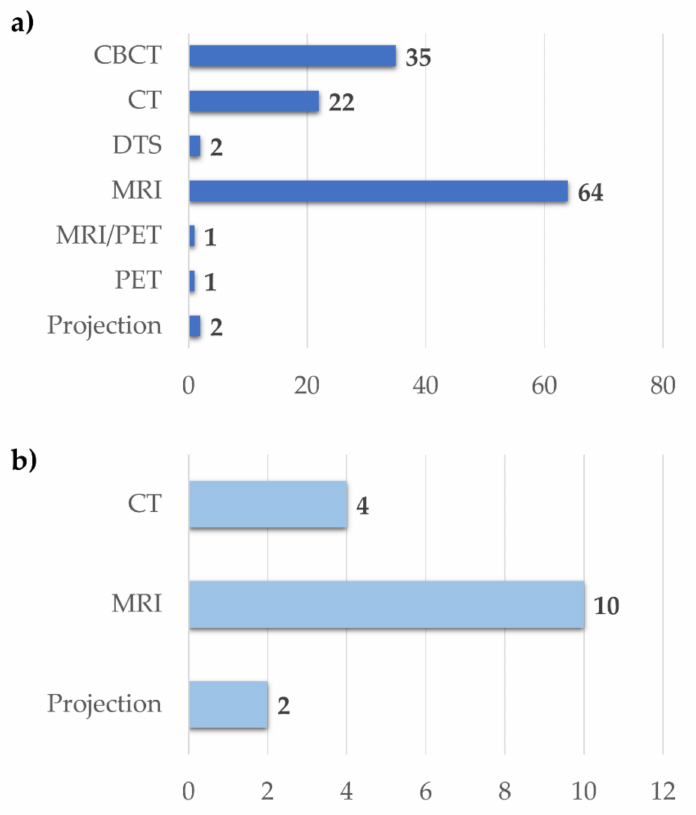
Figure 6. The numbers of identified papers that aimed to generate synthetic images according to the input imaging modality for ( a ) DL- and ( b ) ML-based